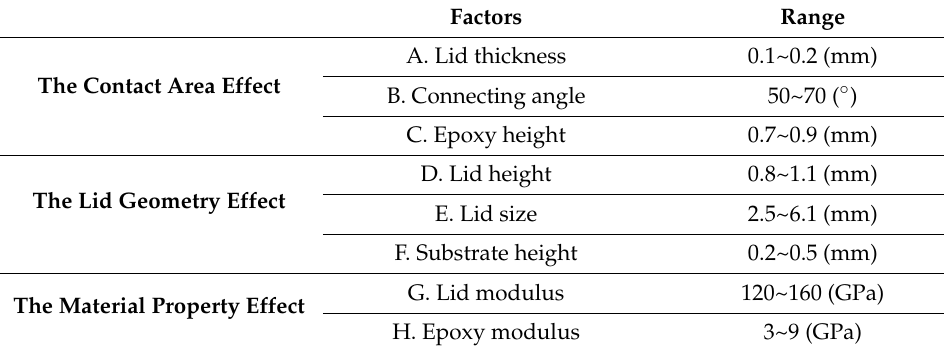
Figure 10. The schematic diagram of design factors. Table 2. The design factors for analyzing the contact stress.